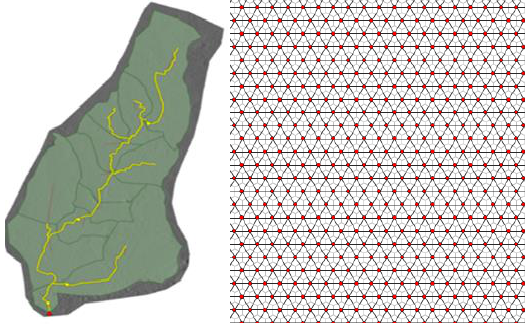
Figure 8: PCSWMM 2D with DEM (left) and model 2D mesh (right)